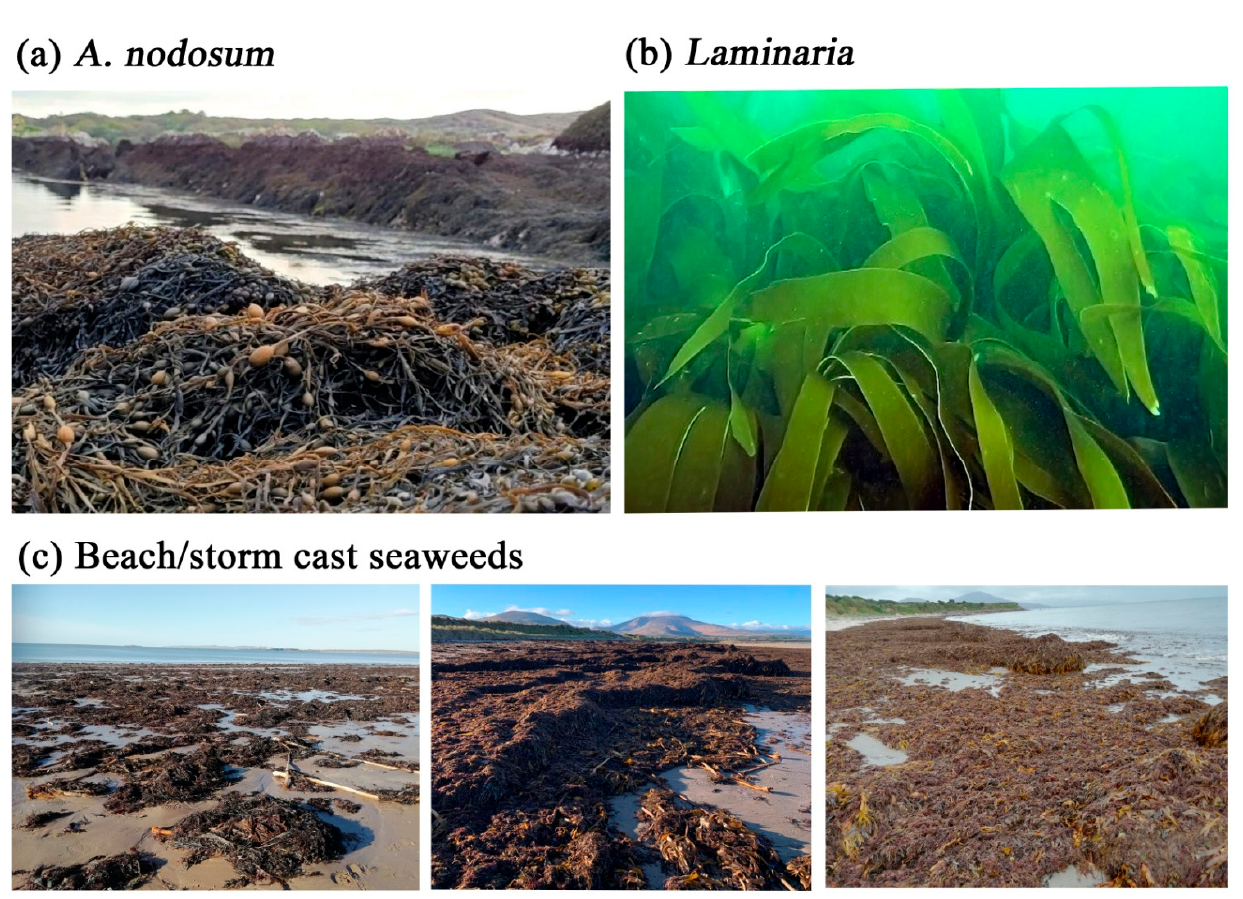
Figure 1. Examples of intertidal, subtidal and beach/storm-cast seaweeds. ( a ) A. nodosum growing in the intertidal zone in County Kerry, Ireland (source: BioAtlantis Ltd.), ( b ) Laminaria growing in subtidal waters of Bantry Bay, County Cork, Ireland (Crowe et al. [43]; unpublished image), and ( c ) beach/storm-cast seaweeds on Derrymore Strand, County Kerry, Ireland (source: BioAtlantis Ltd.).